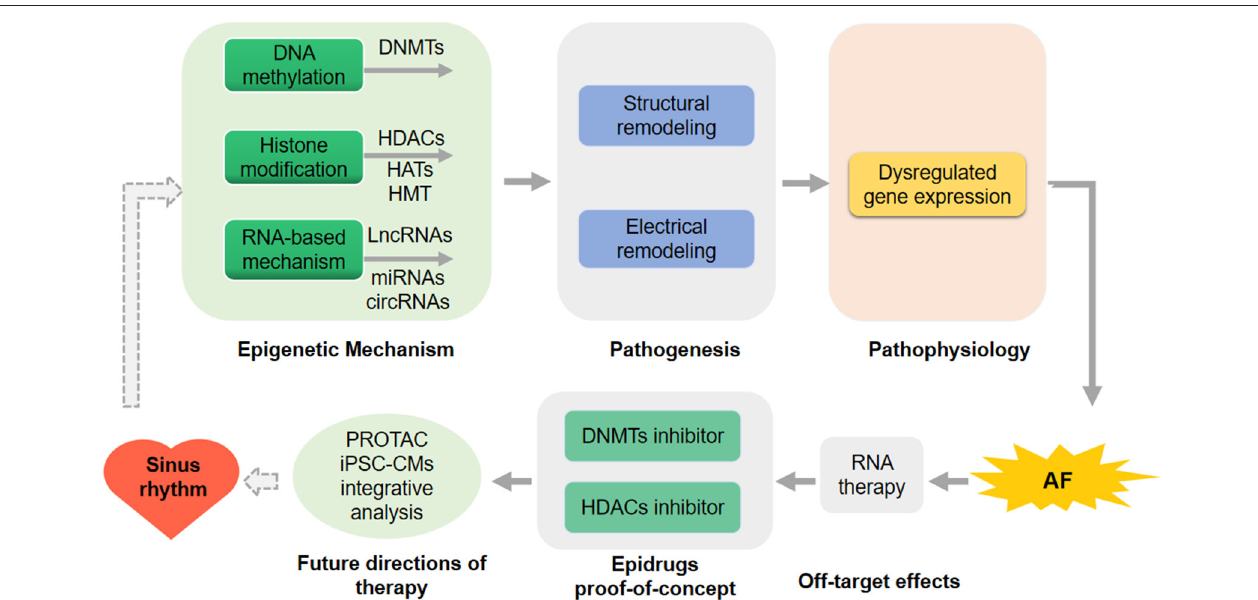
FIGURE 2 | Future direction for atrial fibrillation (AF) prediction and therapeutic intervention. RNA-therapy has not applied in the therapy of human being because of the off-target effects in the human clinical trial. DNA methyltransferases (DNMTs) inhibitors and histone deacetylases (HDACs) inhibitors as the epidrugs have